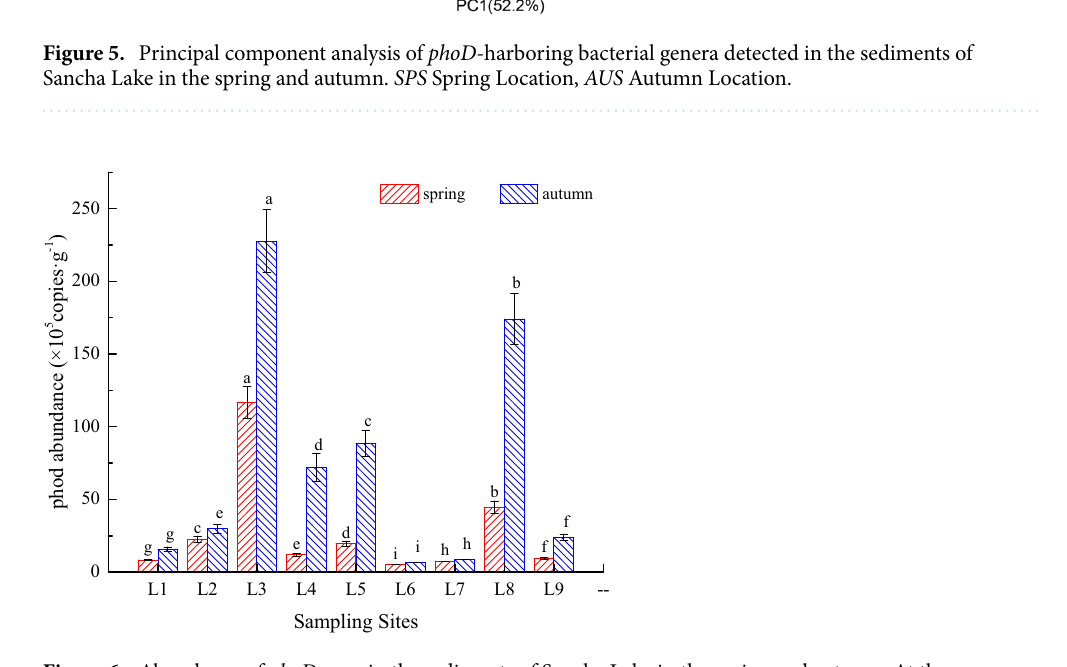
Figure 6. Abundance of phoD gene in the sediments of Sancha Lake in the spring and autumn. At the same sampling time, Bars with different letters (a, b, c, d, e, f, g, h, i) at each location point are significantly different at P < 0.05 according to one-way ANOVA. g is dry